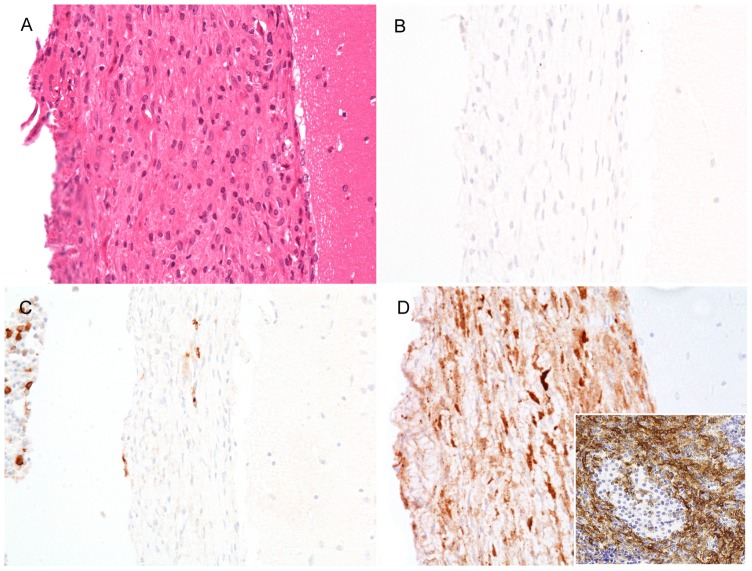
Inflammatory infiltrates are composed of MAC-2 expressing histiocytes.A. H&E-stained section of meninges for orientation of serial sections (B–D). B. Infiltrating cells are negative for CD3 (T-cells). C. Few cells within the thickened meninges are positive (brown) for the B cell marked CD45R (B220). Note bone marrow contains few B-cells (left side of image). D. Majority of infiltrating cells are MAC-2 positive histiocytes. Inset: Pancreas immunostained for the macrophage marker, F4/80. Note that the islet does not stain. All images 20x.